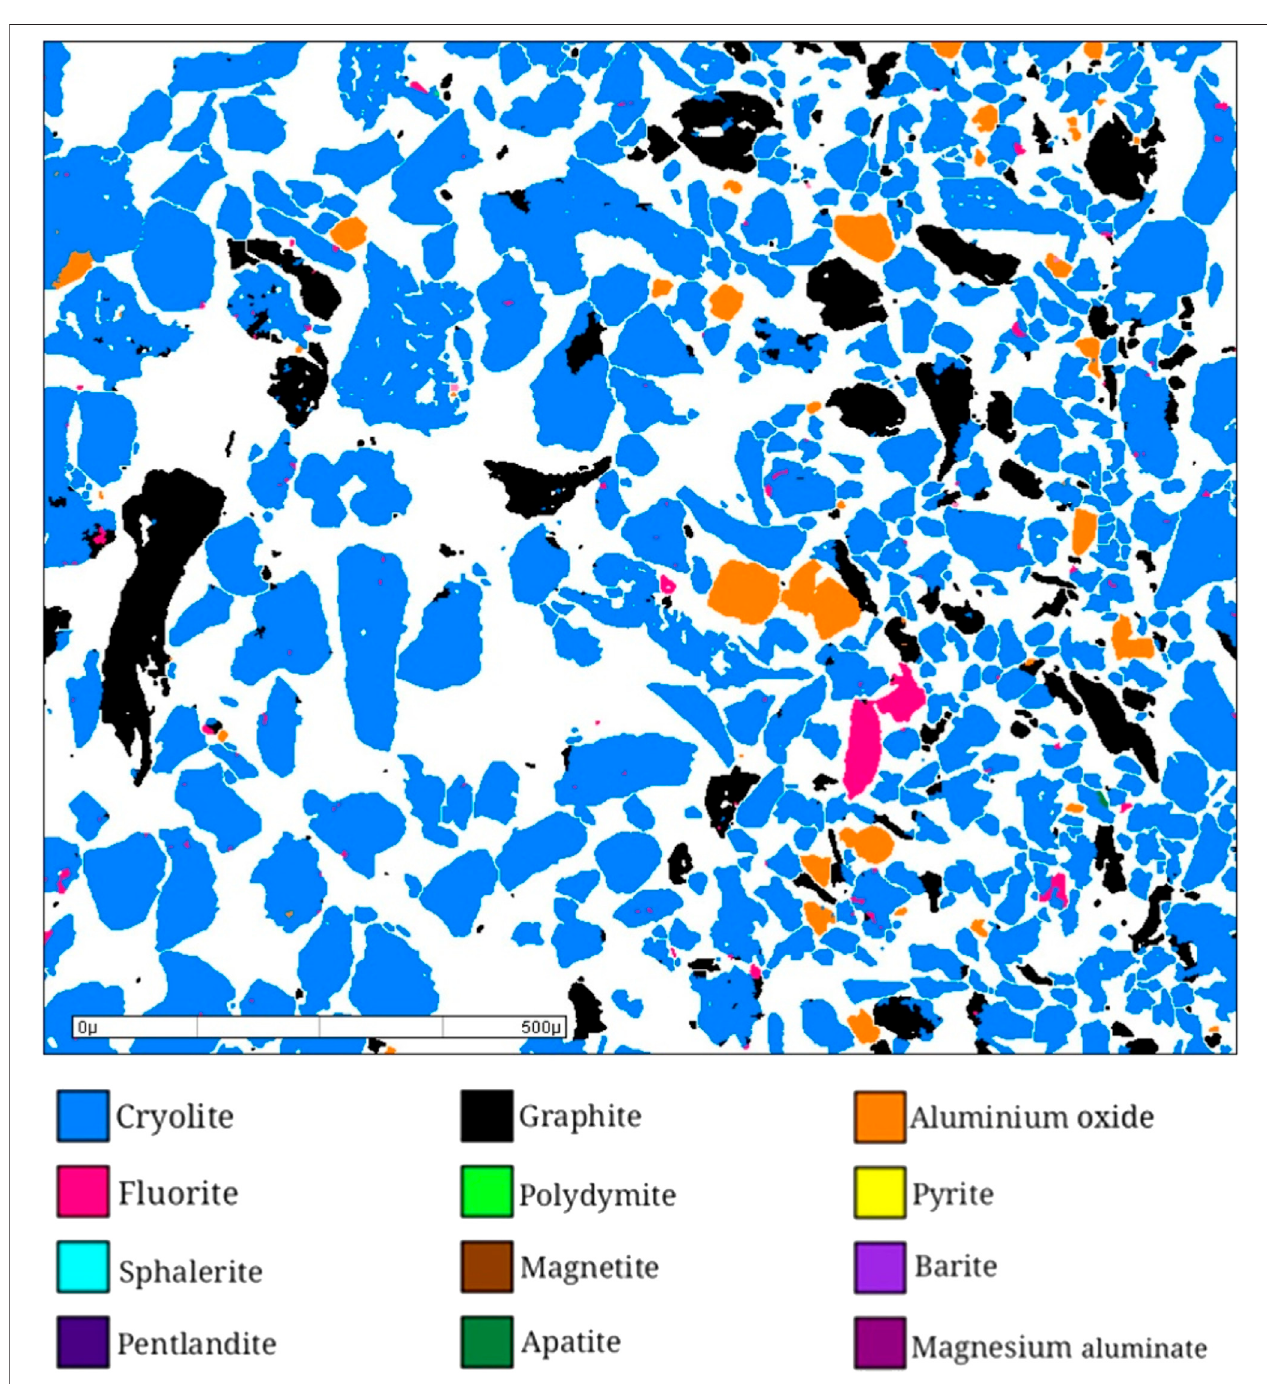
FIGURE 4 | General diagram of MLA analysis of anode carbon redidue (partial area).